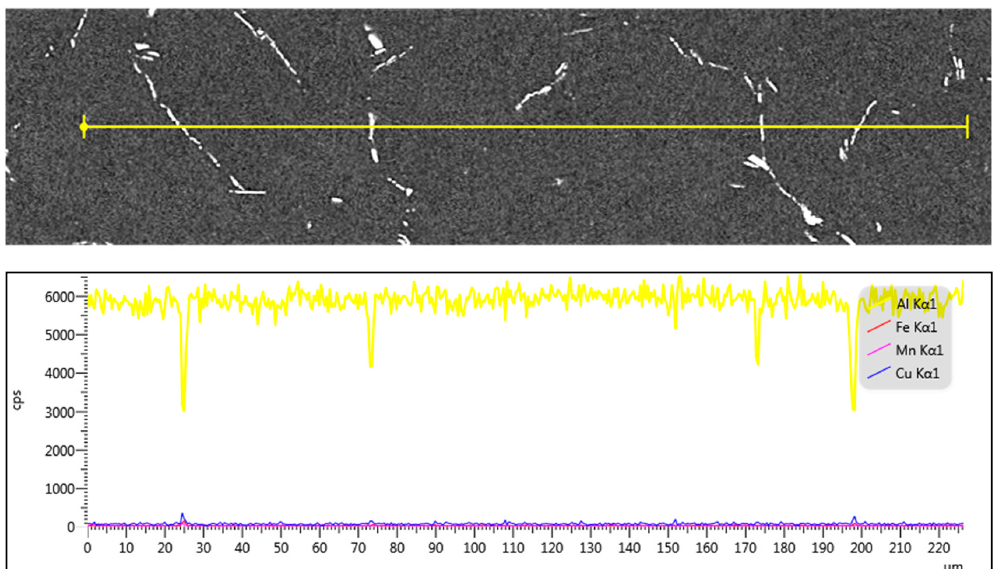
Figure 9. BSEM image and elements line-scanning of alloy homogenized at 535 °C × 10 h.